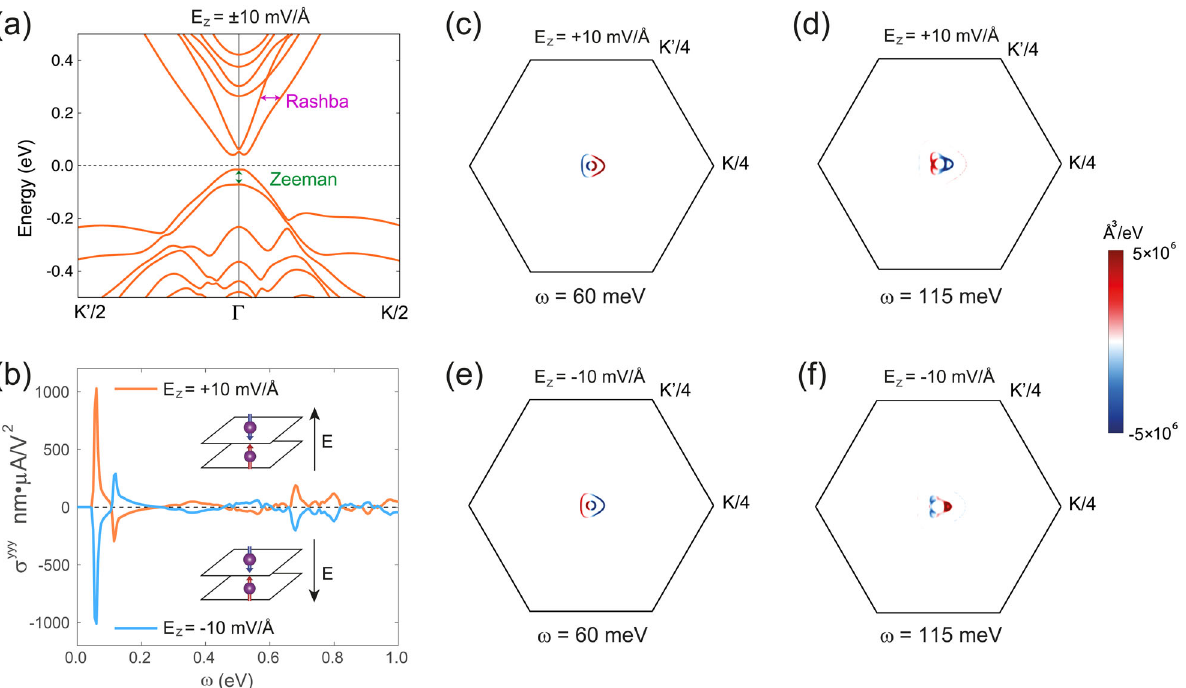
Fig. 3 Normal shift current (NSC) in bilayer MnBi2Te4 with magnetic ordering AFM-z ( ↑↓ ) under external electric fi eld E z ¼ 10mV Å − 1 . a Band structure of bilayer AFM- z under external electric fi eld E z ¼ 10mV Å − 1 . b Frequency-dependent NSC response of bilayer AFM- z MnBi 2 Te 4 under external electric fi eld E z ¼ ±10mV Å − 1 . c – f Microscopic distribution of NSC different frequencies in bilayer AFM- z external electric fi eld E z ¼ ±10mV Å − 1 . It demonstrates that NSC can be switched by applying electric fi eld along + z / − z out-of-plane